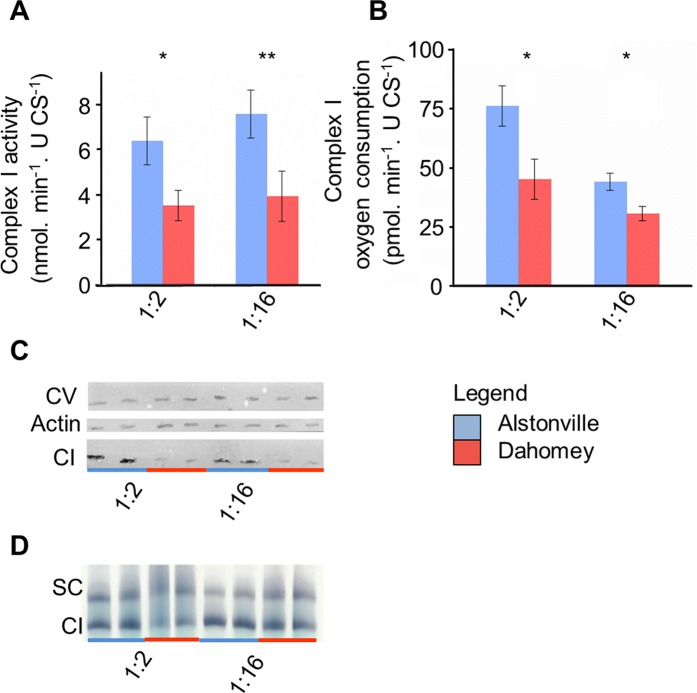
The V161L ND4 amino acid change in complex I of Dahomey mtDNA influenced mitochondrial functions.(A) The activity of complex I is higher in Alstonville larvae (n = 7 biological rep/mitotype/diet- with two failed reactions removed). (B) Oxygen consumption rate with complex I substrates is higher in Alstonville larvae (n = 6 biological rep/mitotype for 1:2 P:C diet; n = 9 biological rep/mitotype for 1:16 P:C diet). (C) Representative western blot showing reduced levels of complex I (CI) in Dahomey compared to Alstonville on both diets. There were no obvious differences in complex V (CV) or actin protein levels. Repeat gels showed all CI bands were the same size. (D) Native protein gel showing reduced activity of the peripheral arm of complex I (CI) and the supercomplex (SC) in larvae harbouring Dahomey mtDNA on both diets. Bars (mean± s.e.m). t-tests between mitotypes * p< 0.05, ** p< 0.01 (see text).